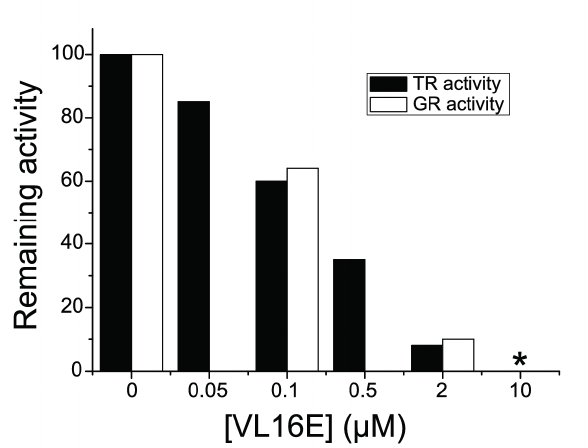
Figure 6. Inhibition of TR and GR activity of purified TGR from M. vogae by VL16E. Residual TR and GR activity as a function of inhibitor concentration is plotted in black and white respectively. Residual GR activity was measured only with 0.01 and 10 µM of inhibitor. (*)TR and GR activities could not be detected. TGR was used at 2nM concentration in all